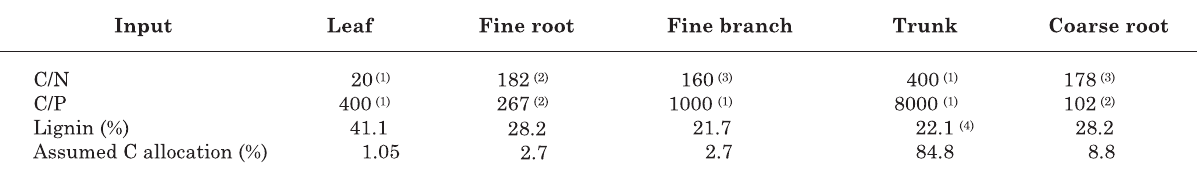
(1) Leite (1996). (2) Ladeira (1999). (3) Faria (2000). (4) Paul & Polglase (2004). The same lignin percentage was assumed for fine and coarse roots. The C allocation of fine roots refers to the sum of C allocation to the medium and fine roots.